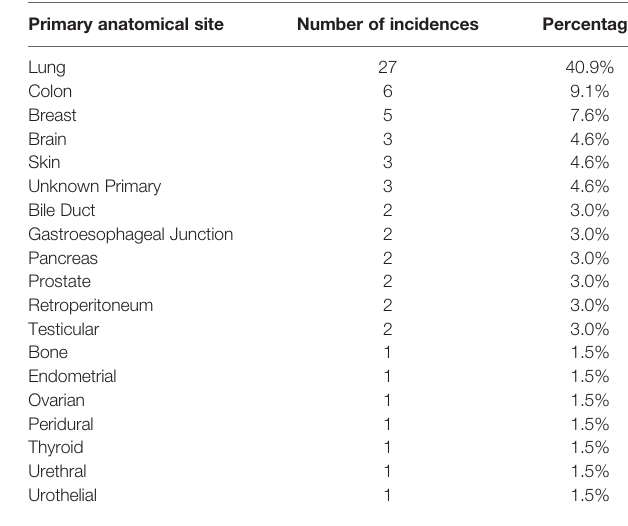
TABLE 3 | Summary of primary identi fi ed cancer anatomical